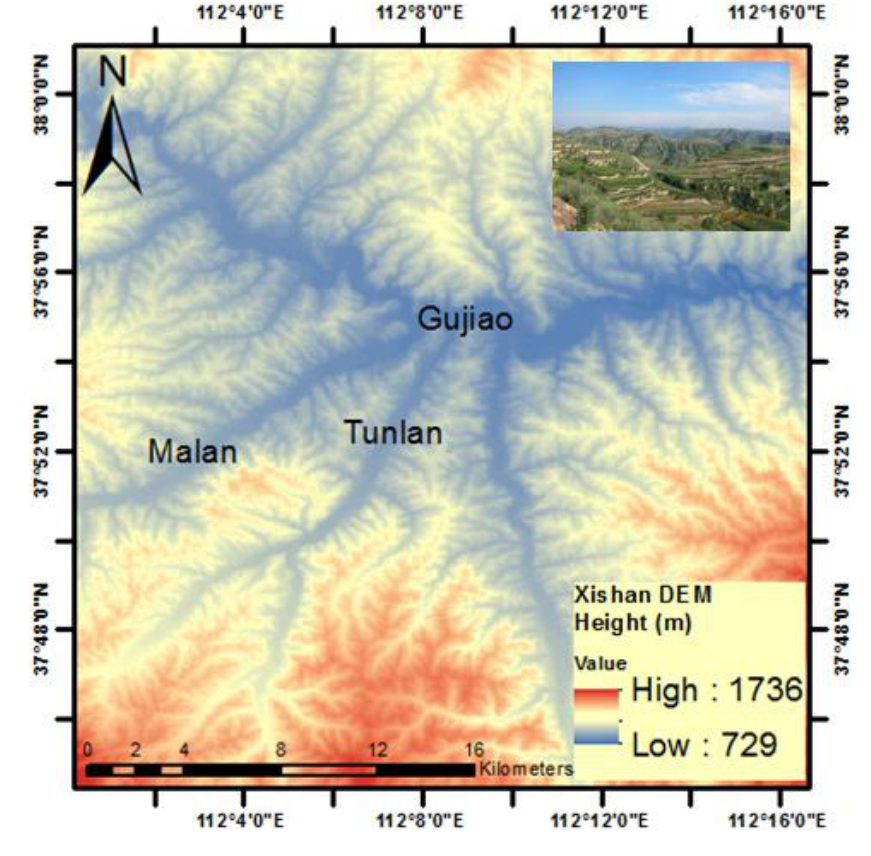
Figure 2. Geography of Xishan shown by 90-m SRTM DEM. The picture at the upper right corner gives a general view of Xishan’s geography. Tunlan mine and Malan town are the AOIs (Area Of Interest) of SBAS-DInSAR processing and TomoSAR processing that will be dealt with later, respectively. Gujiao city is also one object of TomoSAR